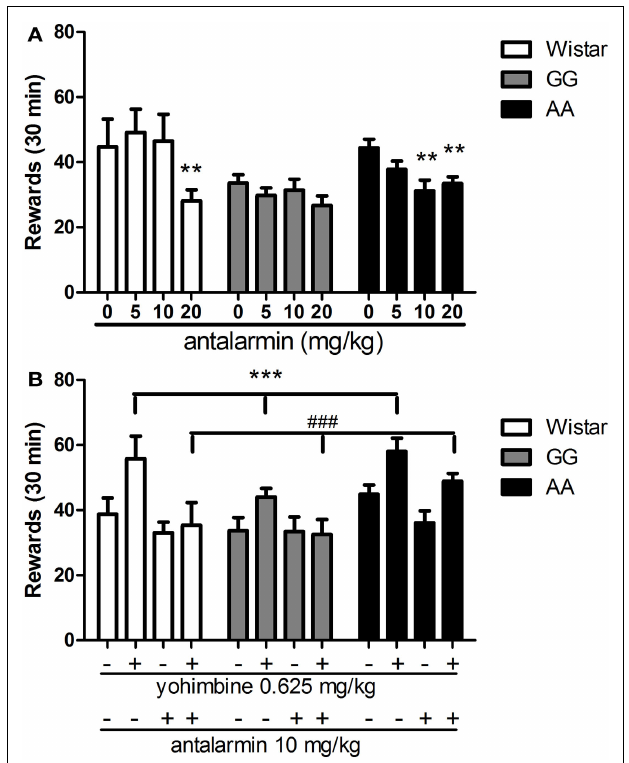
FIGURE 2 | (A) Operant alcohol self-administration inWistar ( n = 10), as well as GG ( n = 14), and AA ( n = 10) msP rats under a fixed ratio 3 (FR-3) schedule of reinforcement is significantly increased by the systemic (i.p.) administration of the pharmacological stressor yohimbine (0.0, 0.625, 1.25, 2.5mg/kg) at the dose of 0.625 and 1.25mg/kg.Values presented are the mean number of rewards earned in 30min ( ± SEM). (B) Operant alcohol self-administration inWistar ( n = 10), as well as GG ( n = 10), and AA ( n = 10) msP rats under a progressive ratio (PR) schedule of reinforcement is significantly increased by the systemic (i.p.) administration of the pharmacological stressor yohimbine at the dose of 0.625mg/kg.Values presented are the mean of break point measure (last ratio completed by the animal ± SEM). ** p < 0.01, *** p < 0.001, significant difference from the collapsed means of vehicle-treated groups (0.0mg/kg).Wistar: white bars; GG: gray bars; AA: black bars. For detailed statistics, see “Results.”